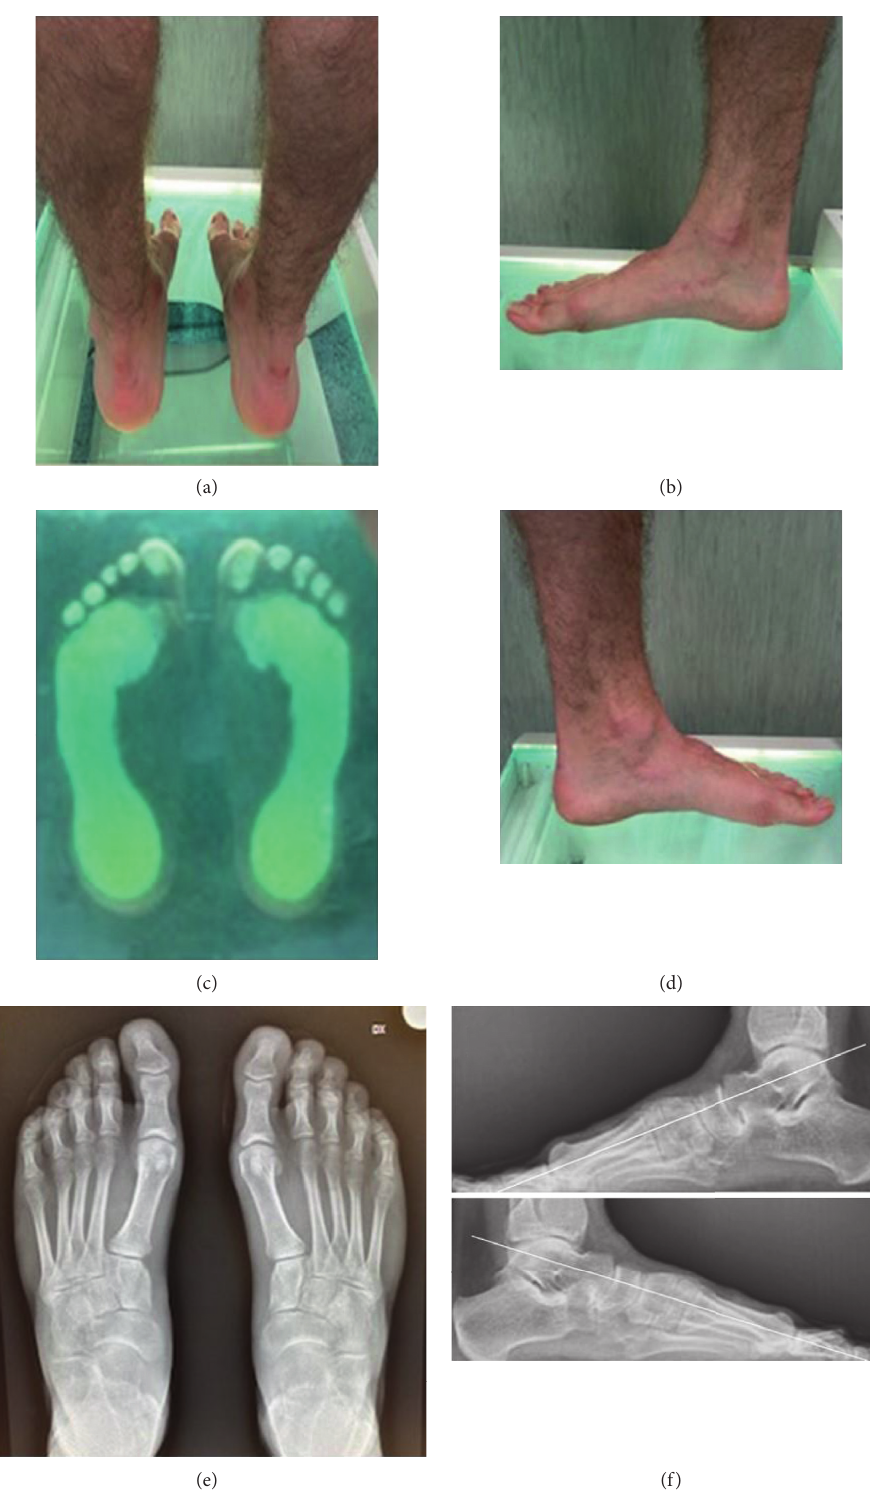
Figure 3: Same patient of Figure 1, at the final follow-up, 11 years after surgery. The patient was pain free. Clinical and podoscopic aspects of both feet showed an excellent result ((a)–(d)). At radiographic examination, Meary’s angle was normal bilaterally (0 ° ), in the absence of midtarsal joint osteoarthritis ((e) and